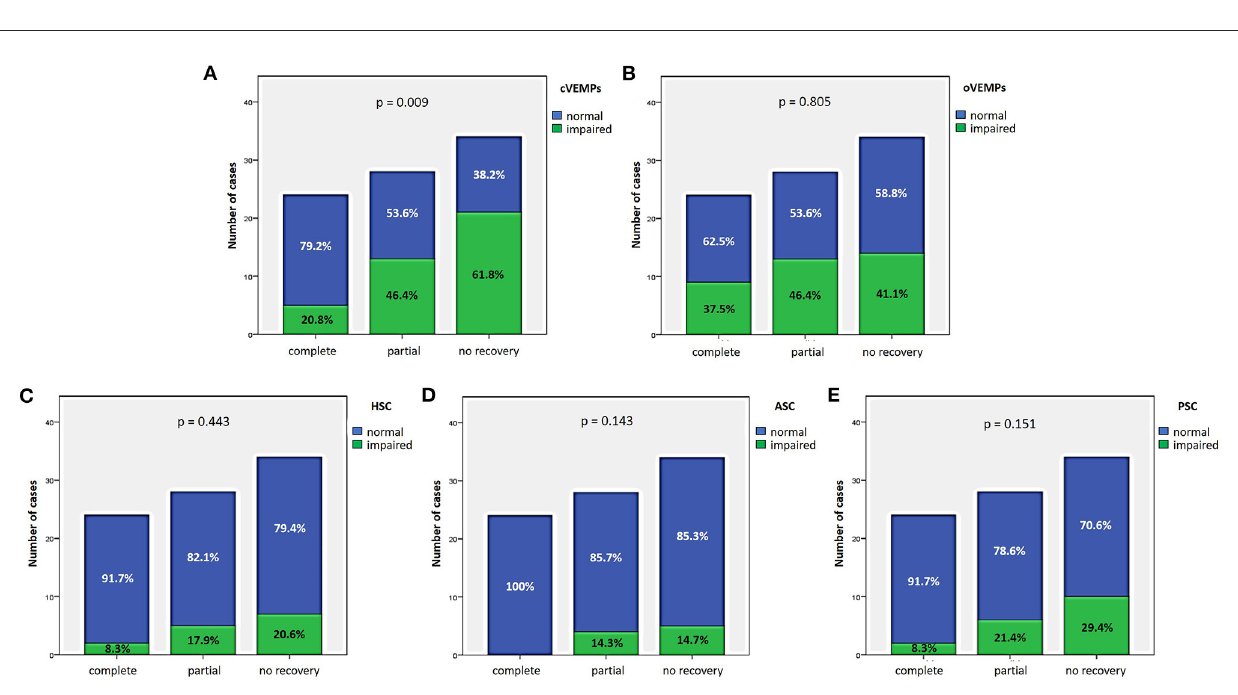
FIGURE8 Bar plots showing the different distribution of otolith (A, B) and semicircular canal impairment (C–E) ipsilesionally to SSNHL, as measured by cVEMPs, oVEMPs, and vHIT, respectively, once divided the cohort according to hearing recovery. Relative percentages are reported in each column and p -value of categorical comparisons are reported. ASC, anterior semicircular canal; cVEMPs, cervical vestibular-evoked myogenic potentials; HSC, horizontal semicircular canal; oVEMPs, ocular vestibular-evoked myogenic potentials; PSC, posterior semicircular canal; SSNHL, sudden sensorineural hearing loss; vHIT, video-head impulse